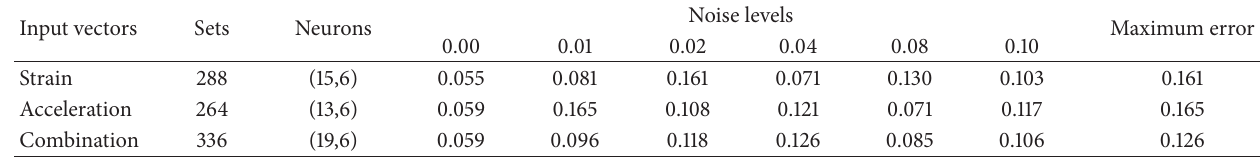
Table 22: The identification errors of forecasted cases based on three different input